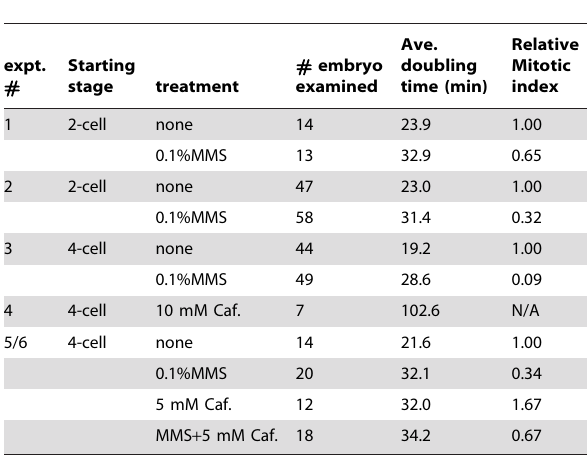
Table 1. Summary of results from six